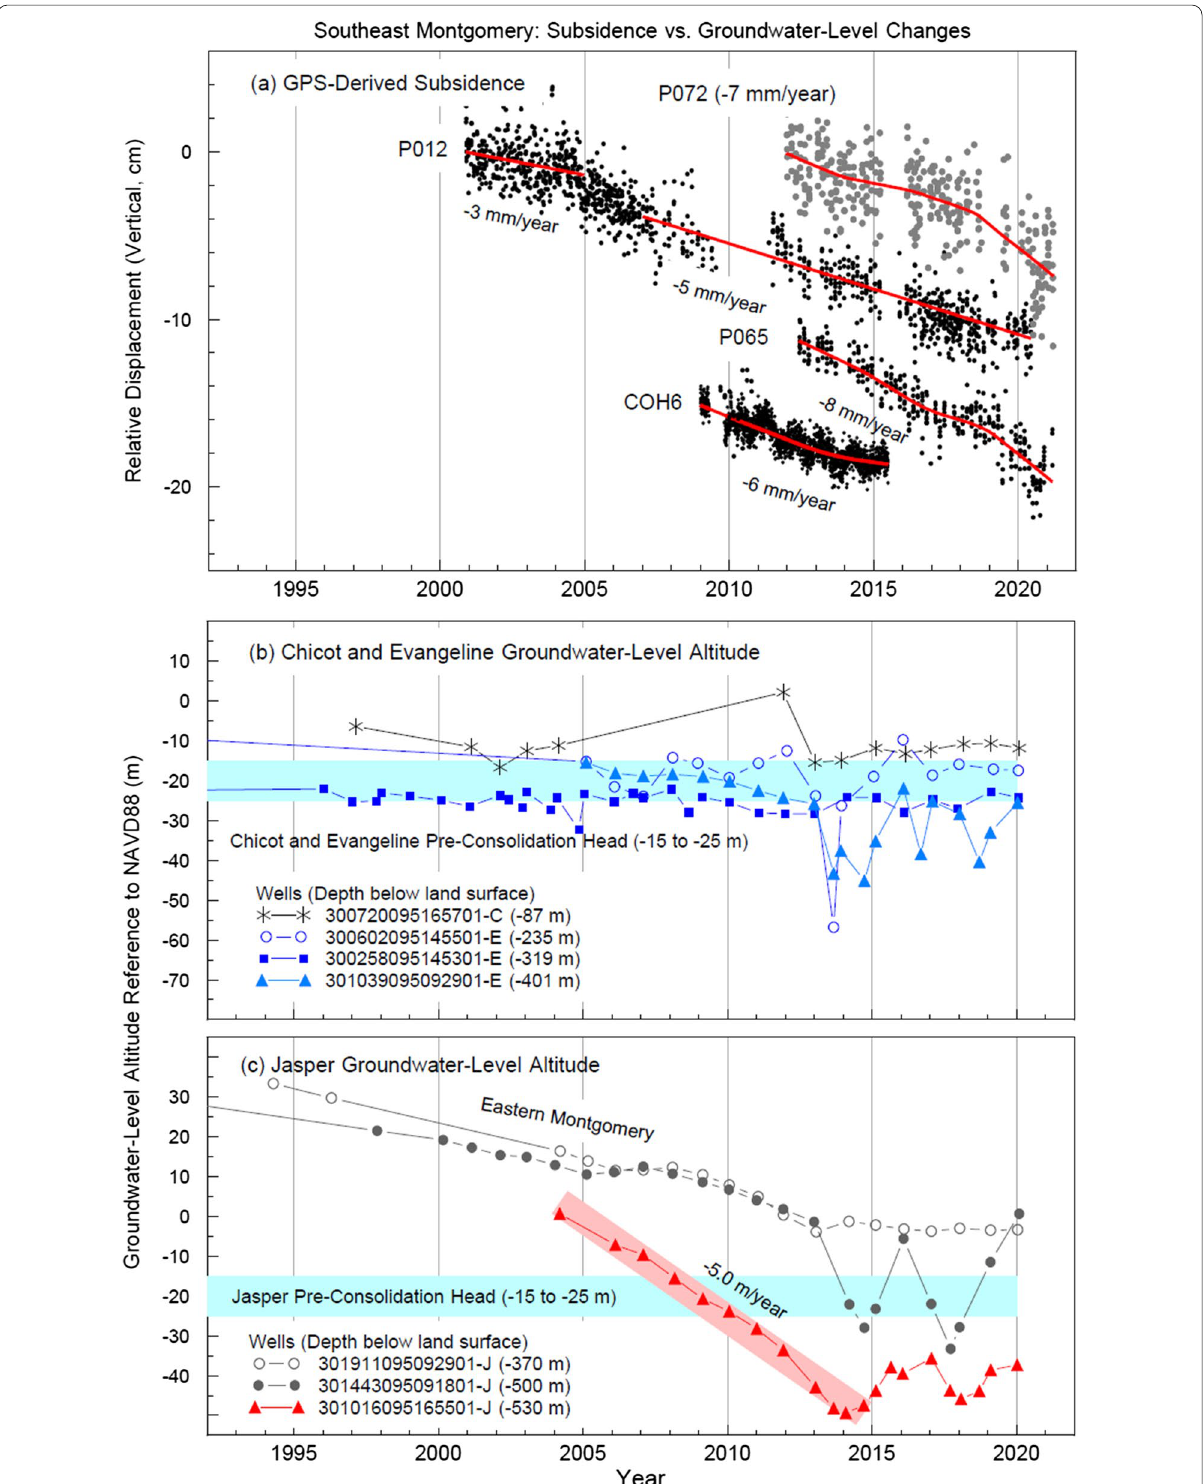
Fig. 16 GPS-derived land subsidence and groundwater levels in southeastern Montgomery County. The locations of GPS stations and groundwater wells are marked in Fig.